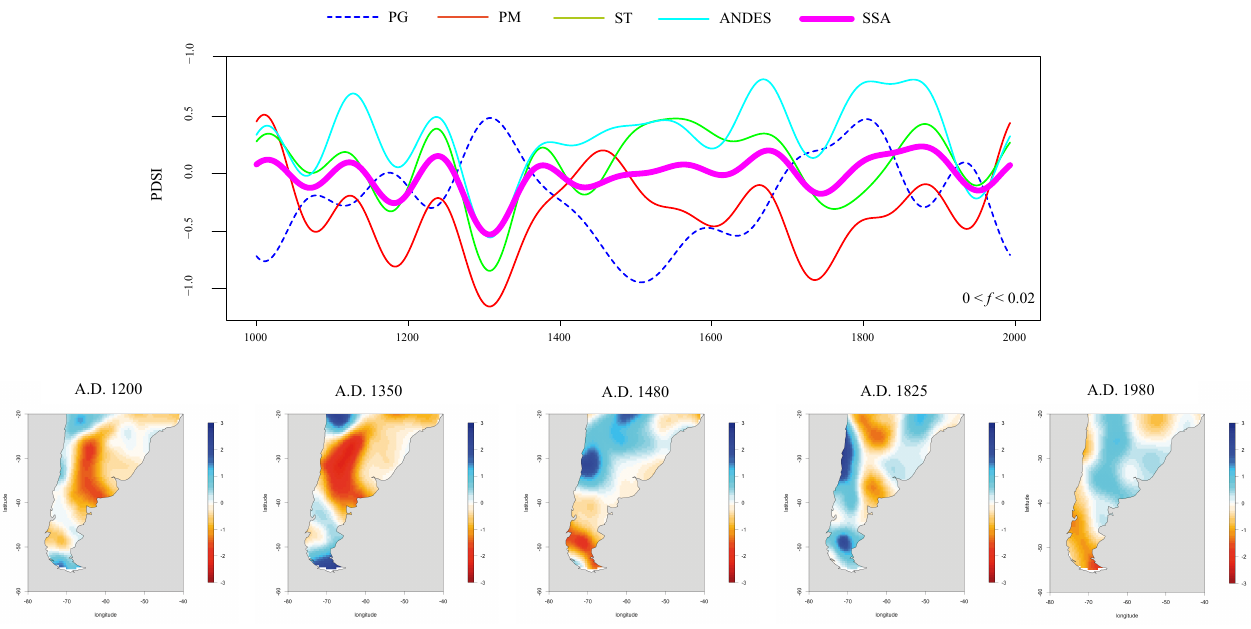
Figure 12. Smoothed summer PDSI reconstruction for each region of SSA emphasizing the antiphase between SP and the rest of the continent. Smooth lines correspond to 50 years low pass filters ( f ≤ 0.02). Example maps of 30 year periods centered on A.D. 1200, 1350, 1690, 1825, and 1980 are shown.